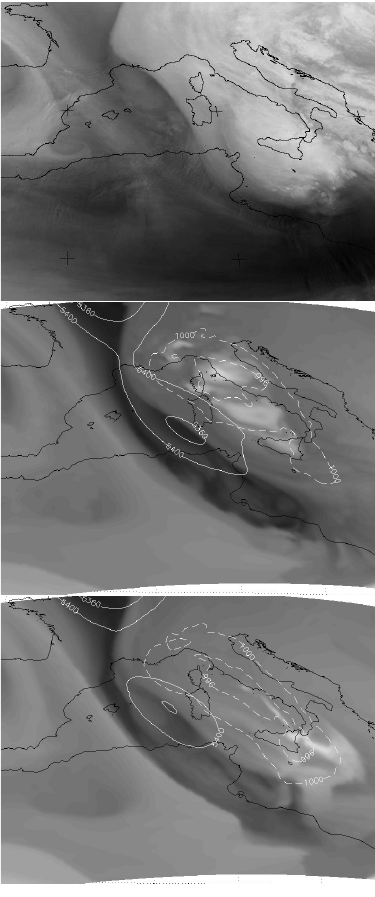
Fig. 9. MSG 6.2 WV image (top panel) and QBOLAM (middle panel) and BOLAM 2007 (bottom panel) PWV forecasts valid for 1500 UTC 11 December 2008. Fig. 9. PWV analysis at 15:00UTC 11 December 2008. Top: MSG 6.2 WV image; middle: QBOLAM PWV image; bottom: BOLAM 2007 PWV